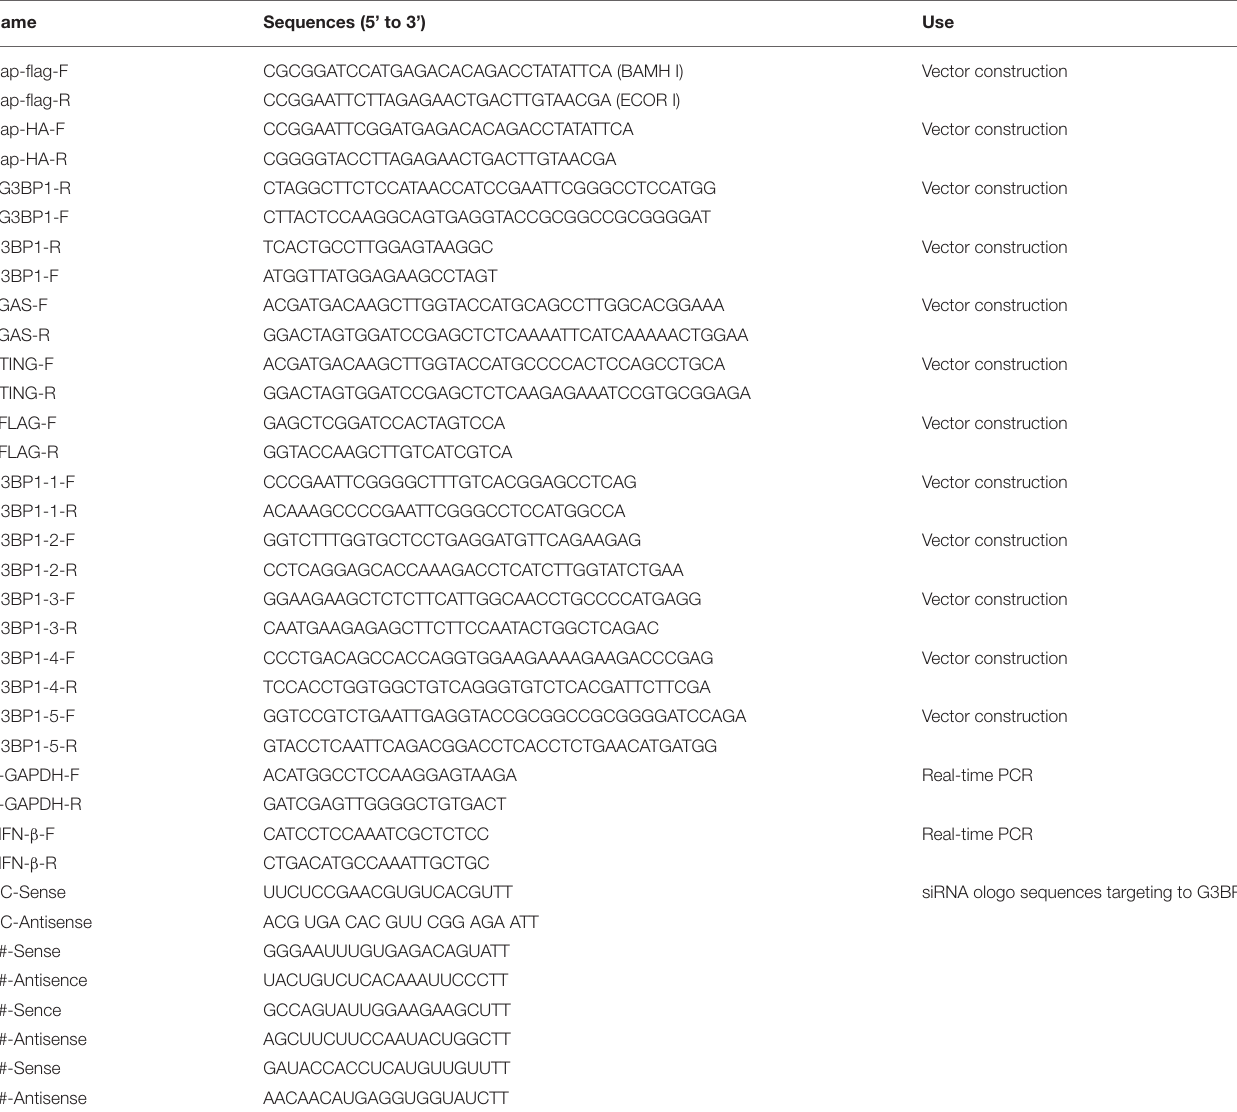
TABLE 1 | The primer